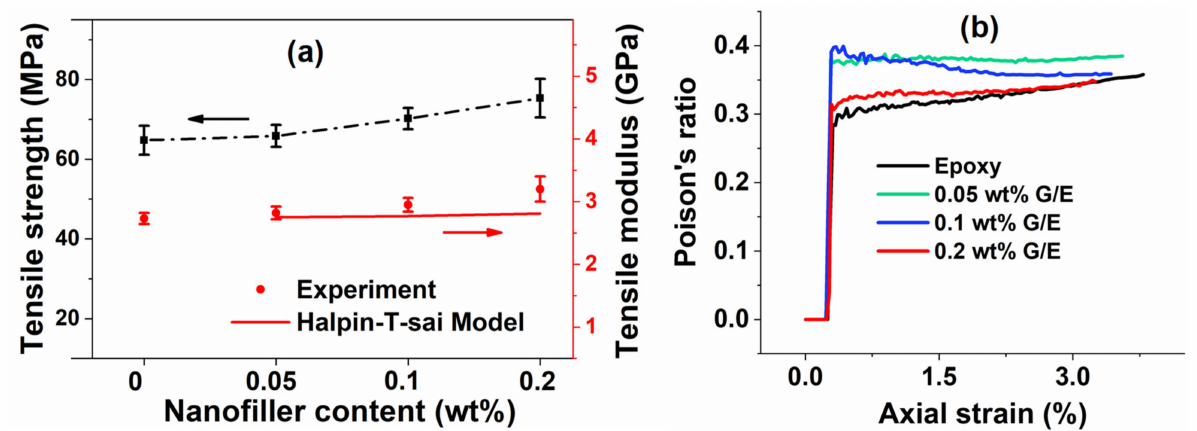
Figure 6. ( a ) Tensile properties at different GO contents and ( b ) Poisson’s ratio values of different